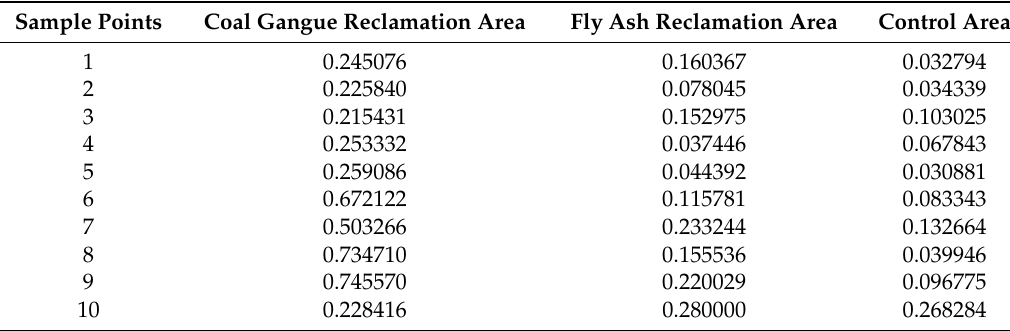
Table 7. Cd concentration of the wheat in three different areas